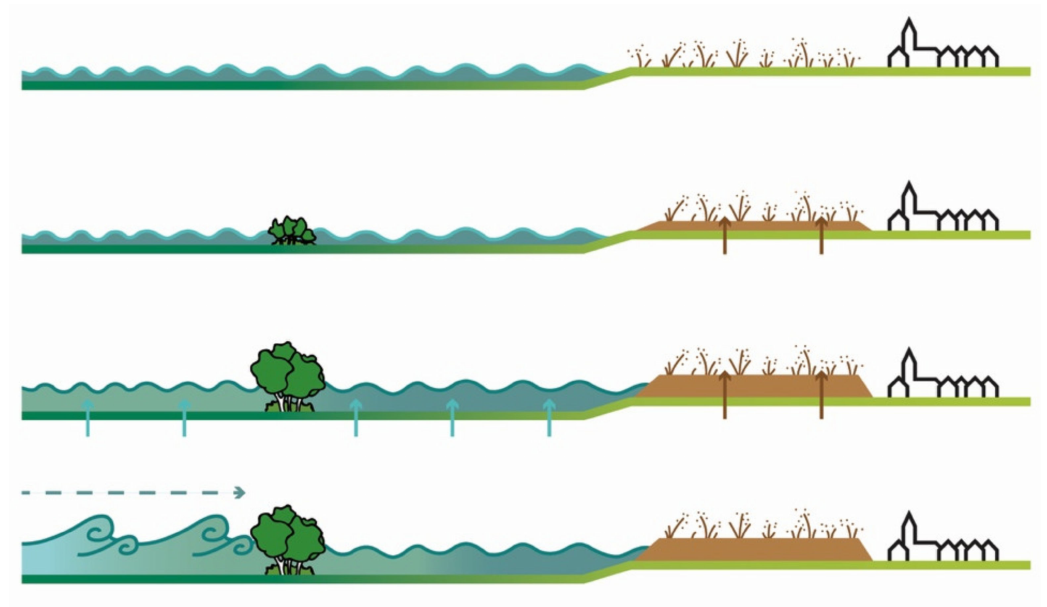
Figure 17. Peat formation.